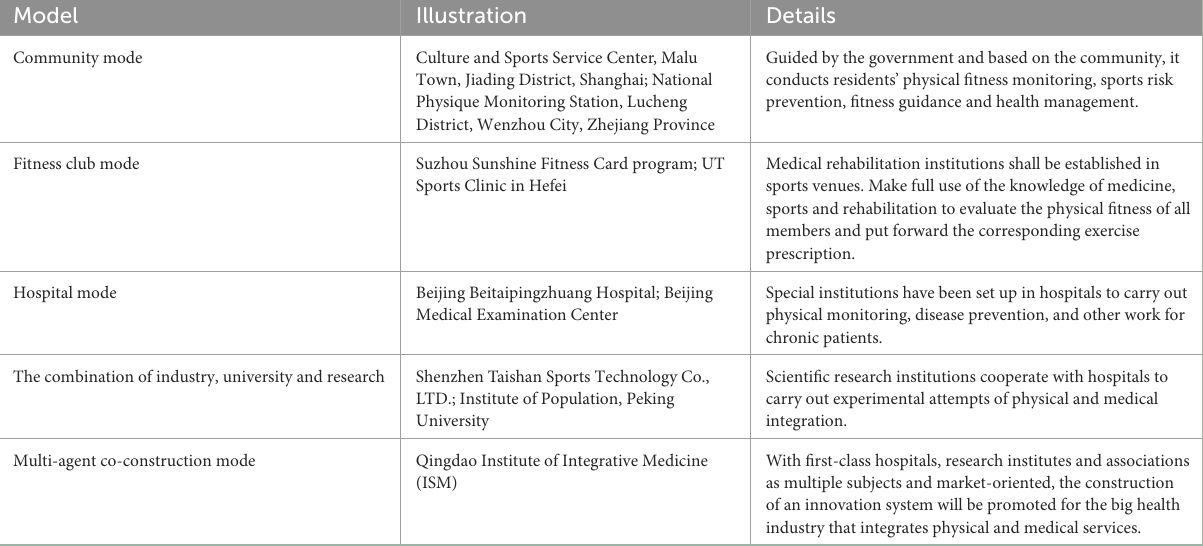
TABLE 2 The development mode of the ISM in China.